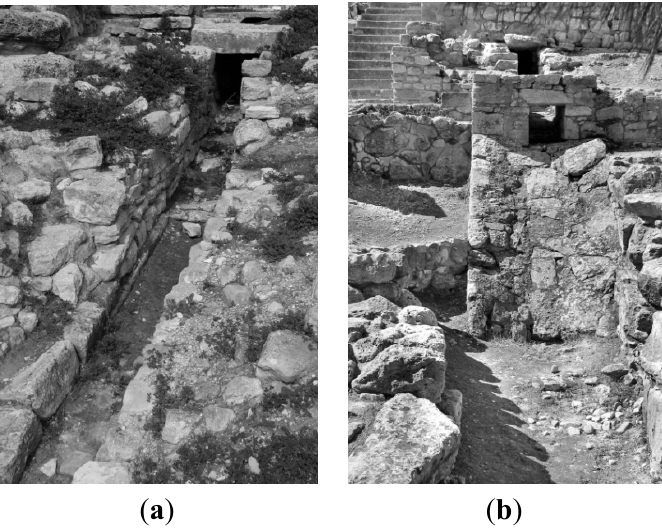
Figure 6. Minoan central sewerage and drainage systems: at palace of Phaistos ( a ) and at palace of Knossos ( b